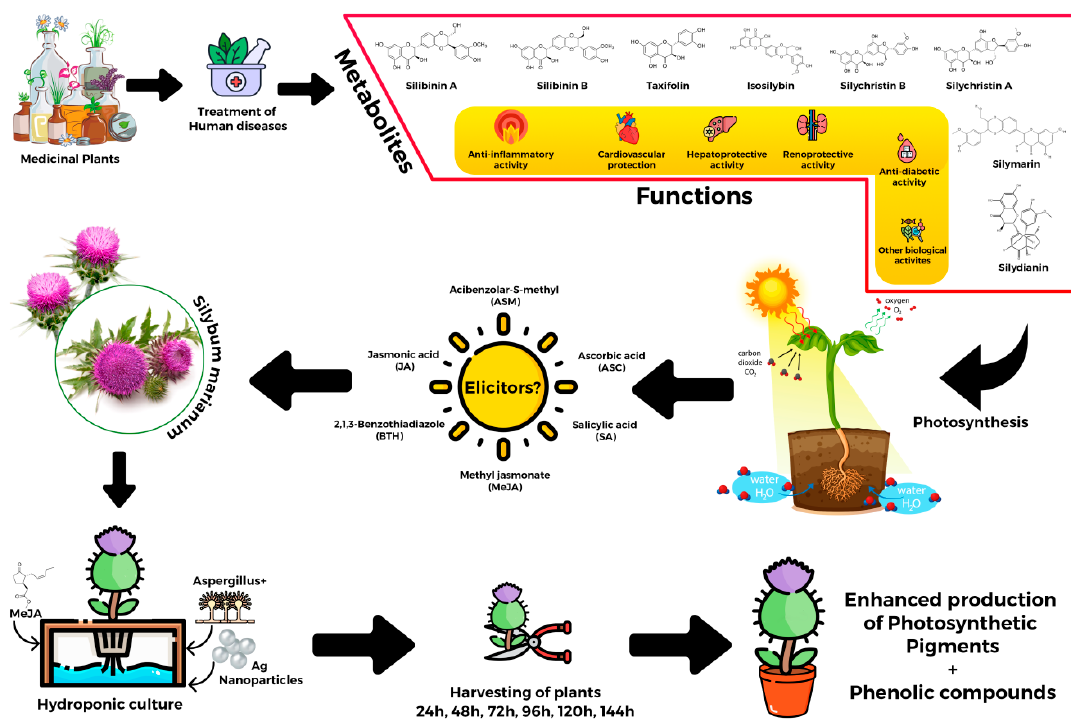
Figure 6. Schematic representation of experiments conducted for study in hydroponics .